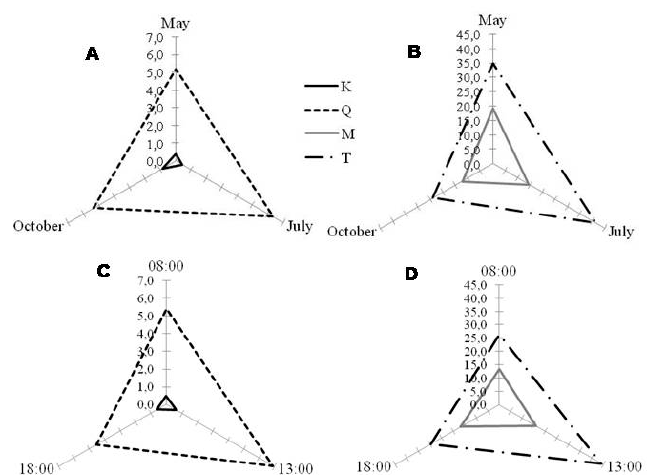
Figure 5. Monthly ( A and B ) and diurnal ( C and D ) variation of the different polyphenolic classes detected in Cistus incanus leaf ethanolic extracts: K—kaempferol derivatives; M—myricetin